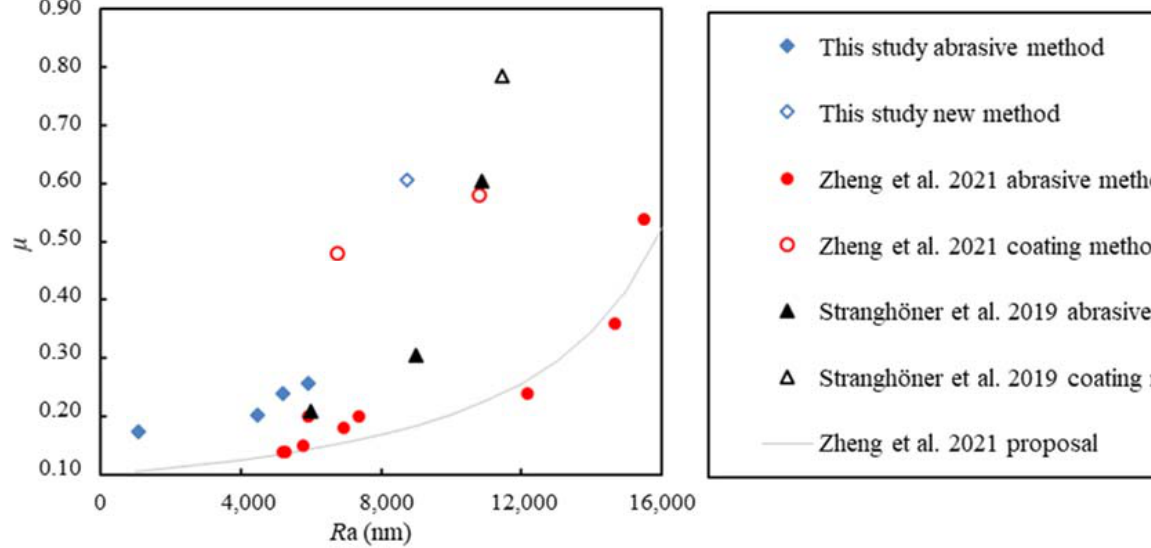
Figure 8. Relationship between slip factor and roughness 10.